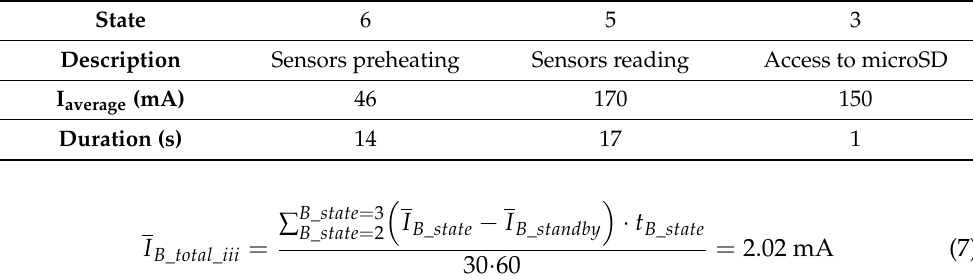
Table 8. Description of functional states of node B—mode (iii).